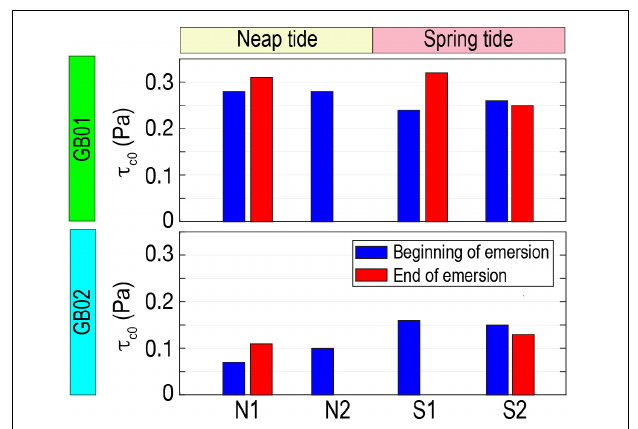
FIGURE 6 | The surface erosion threshold ( τ c0 ) at GB01 (upper panel) and GB02 (lower panel) sites during N1, N2, S1, and S2 periods (see Figure 2A ).